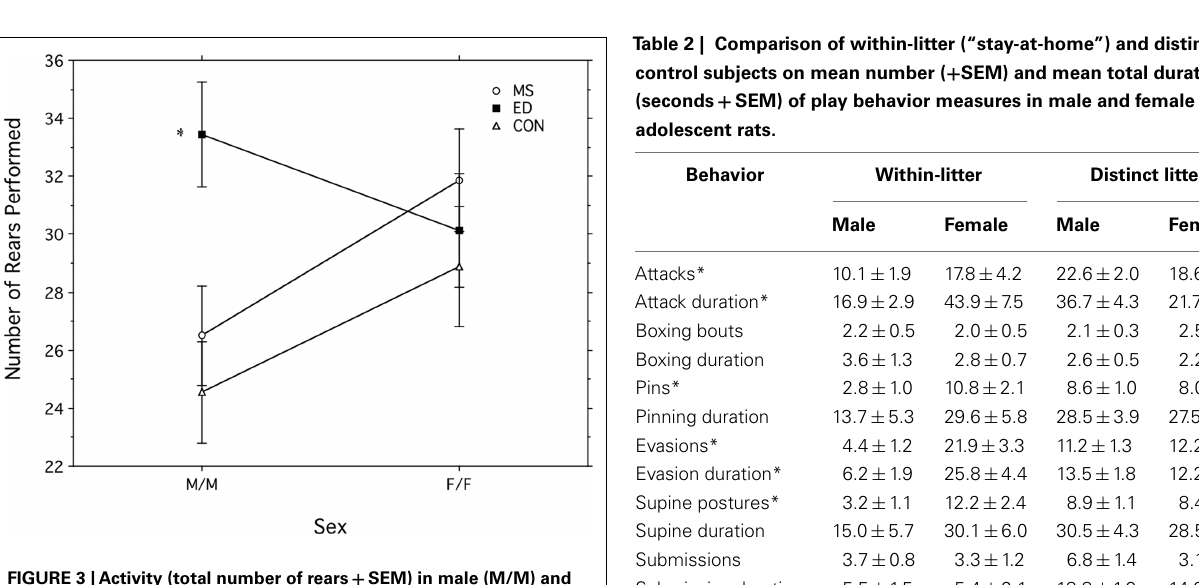
FIGURE 3 |Activity (total number of rears + SEM) in male (M/M) and female (F/F) pairs in one of three postnatal treatment condition: maternal separation (MS), early deprivation (ED), or control. *Significantly different from other male conditions.